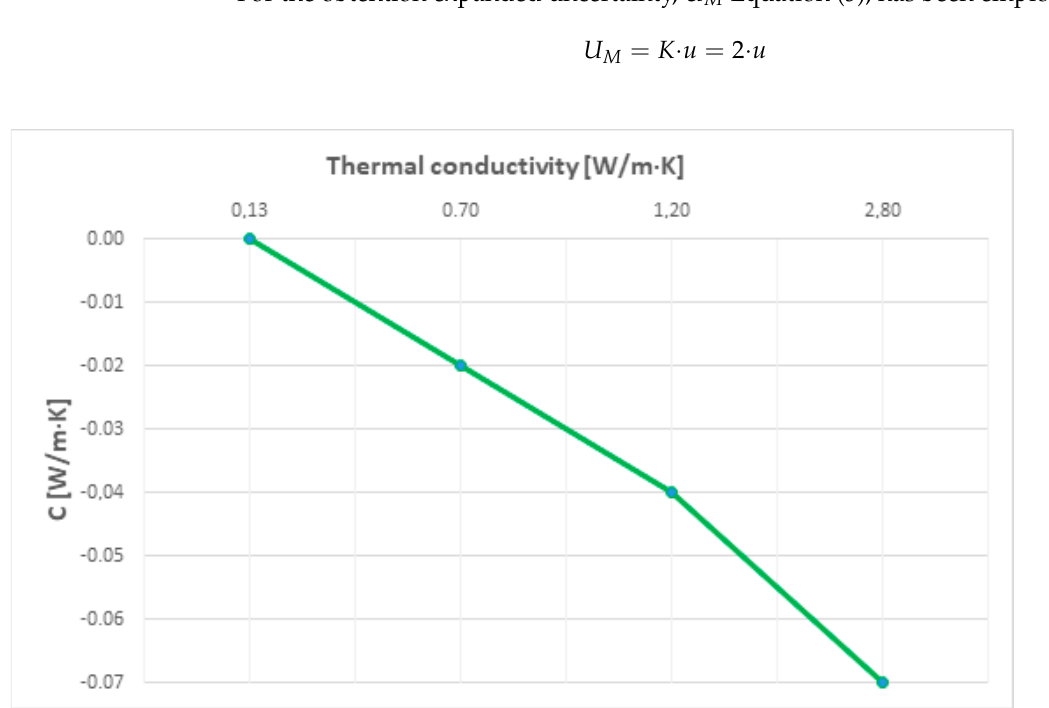
Figure 9. Graph for obtaining the calibration correction in the TCMA.